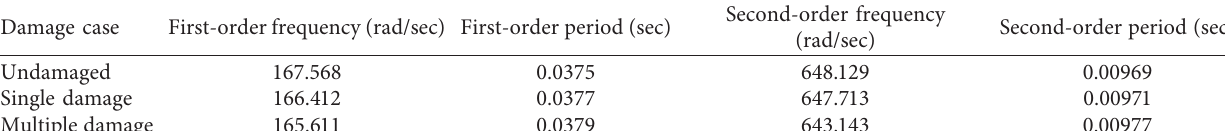
Table 2: Modal information of simply supported